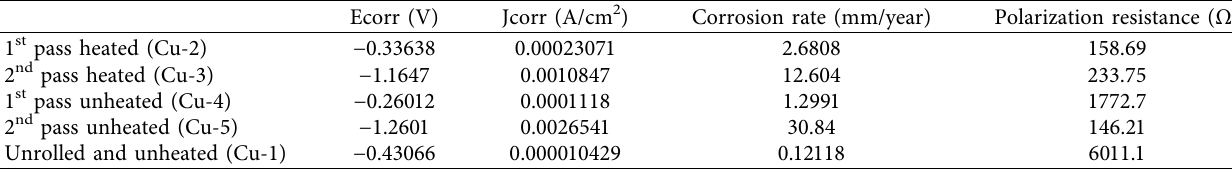
Table 8: Polarization data for copper during the ARB experiment with heated and unheated samples. Ecorr (V) Jcorr (A/cm 2